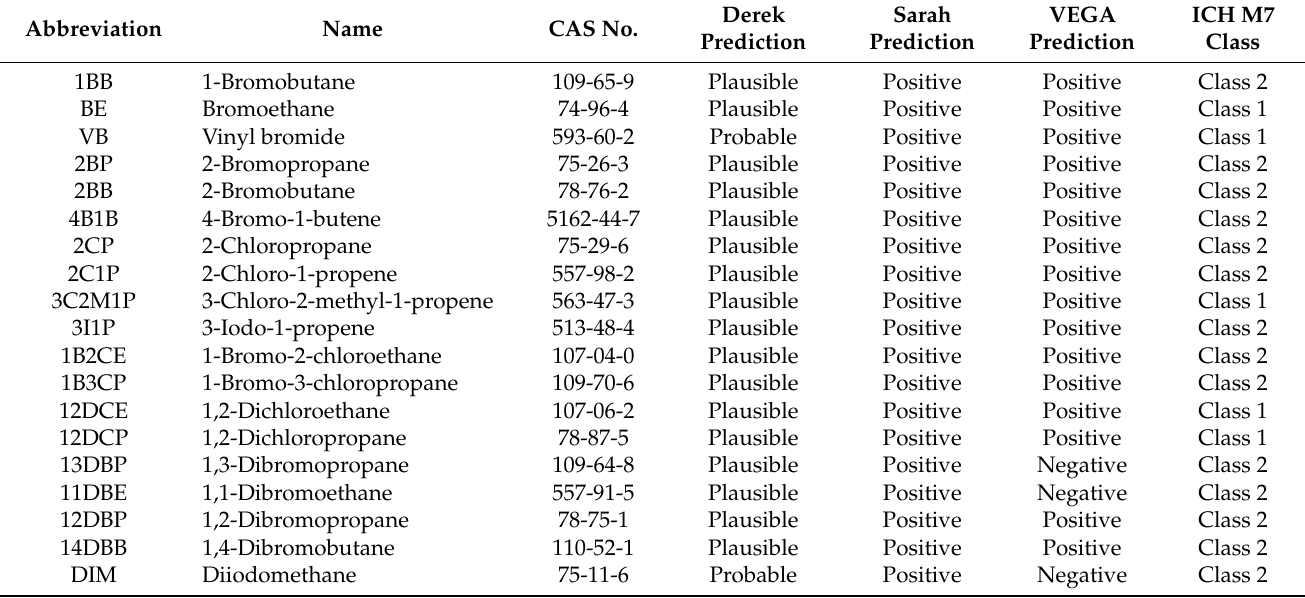
Table 1. The genotoxicity predictions for 19 selected alkyl